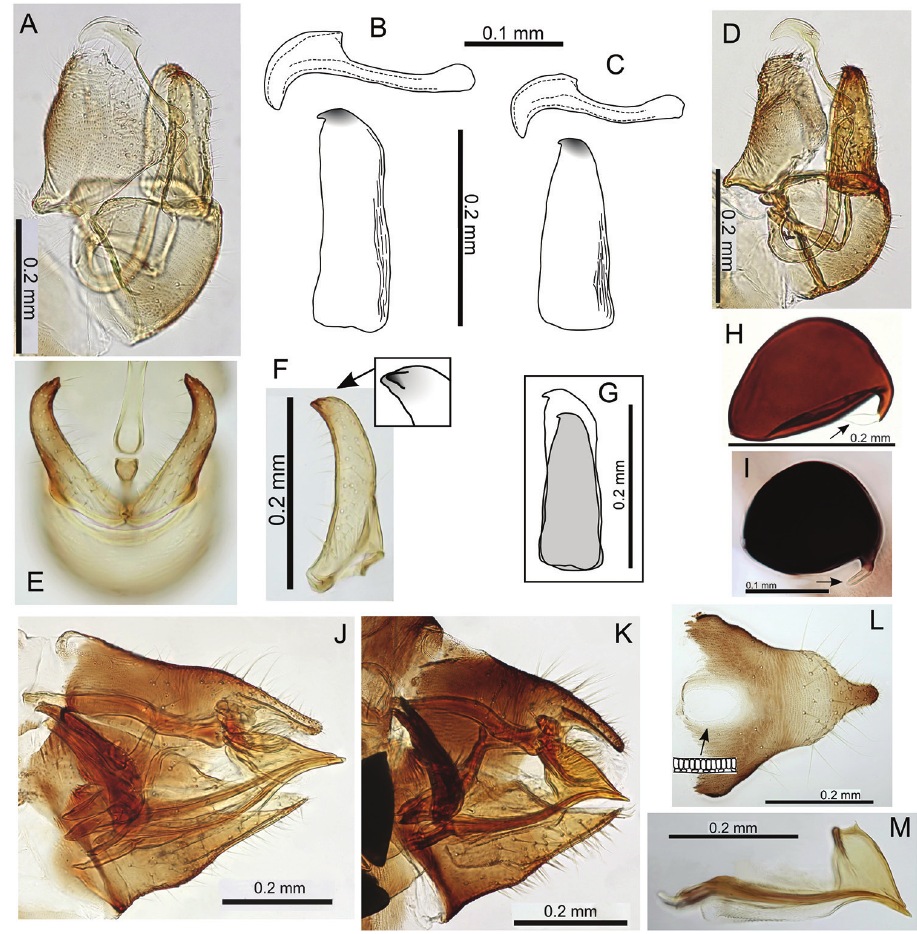
Figure 43. Pariaconus pele sp. n. A–B form pele : A male terminalia B aedeagus and paramere C, D–F form kohalensis : C aedeagus and paramere D male terminalia E male terminalia (posterior view) F paramere (posterior view) with apex detail (inset) G paramere shape variation comparison H–I egg (pedicel indicated): H form pele I form kohalensis J female terminalia, form pele K–M form kohalensis : K female terminalia L female proctiger (dorsal view) with anal ring cells detailed M